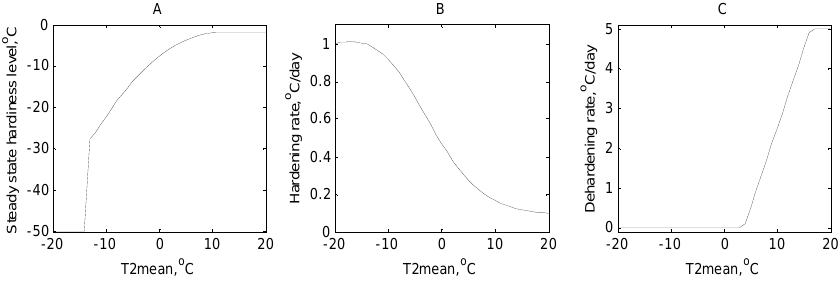
Fig. 1. Relations between daily mean temperature and (A) desired hardiness level, (B) hardening rate and (C) dehardening rate, used for Figure 1: Relations between daily mean temperature and A) desired hardiness level, B) calculating the seasonal changes in cold hardness level. hardening rate and C) dehardening rate, used for calculating the seasonal changes in cold Table 1. Seven measures for assessing the severity of spring frost events were derived from a spring backlash index (SBI) and a hardness level.